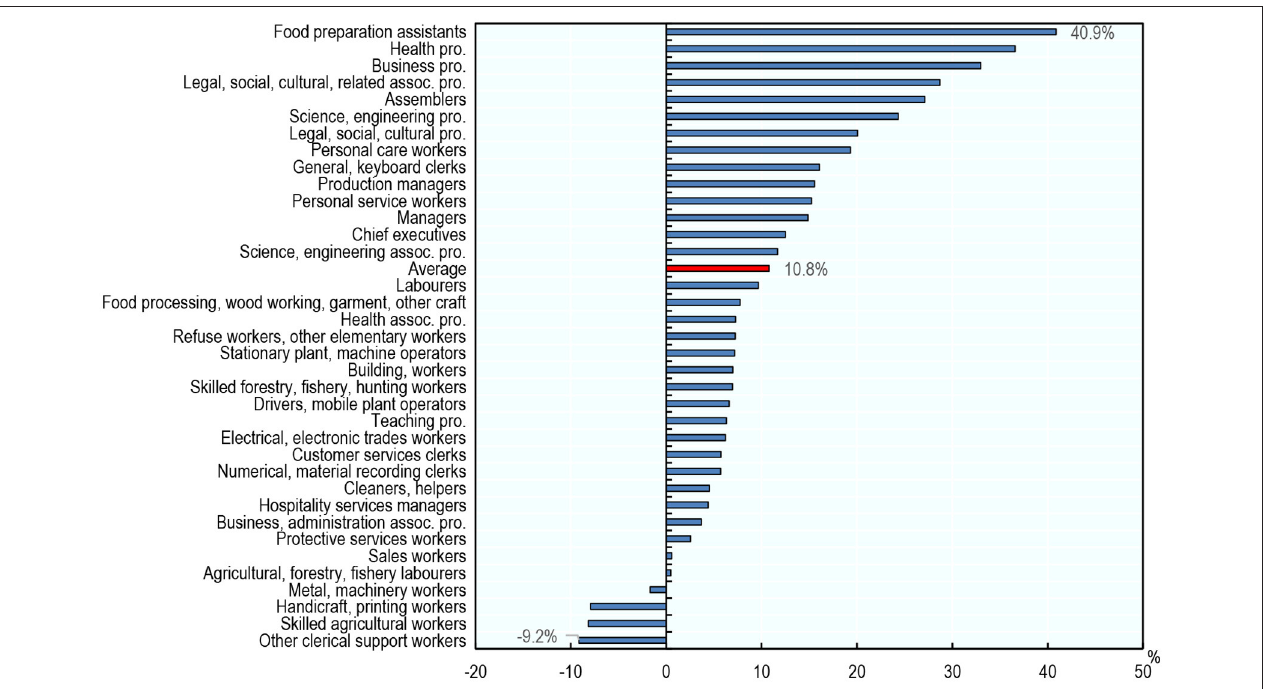
FIGURE 10 | Employment has grown in most occupations between 2012 and 2019. Average percentage change in employment level across countries by occupation, 2012–2019. Occupations are classified using two-digit ISCO-08. The averages presented are unweighted averages across the 23 countries analyzed. Source: ENOE, EU-LFS, and